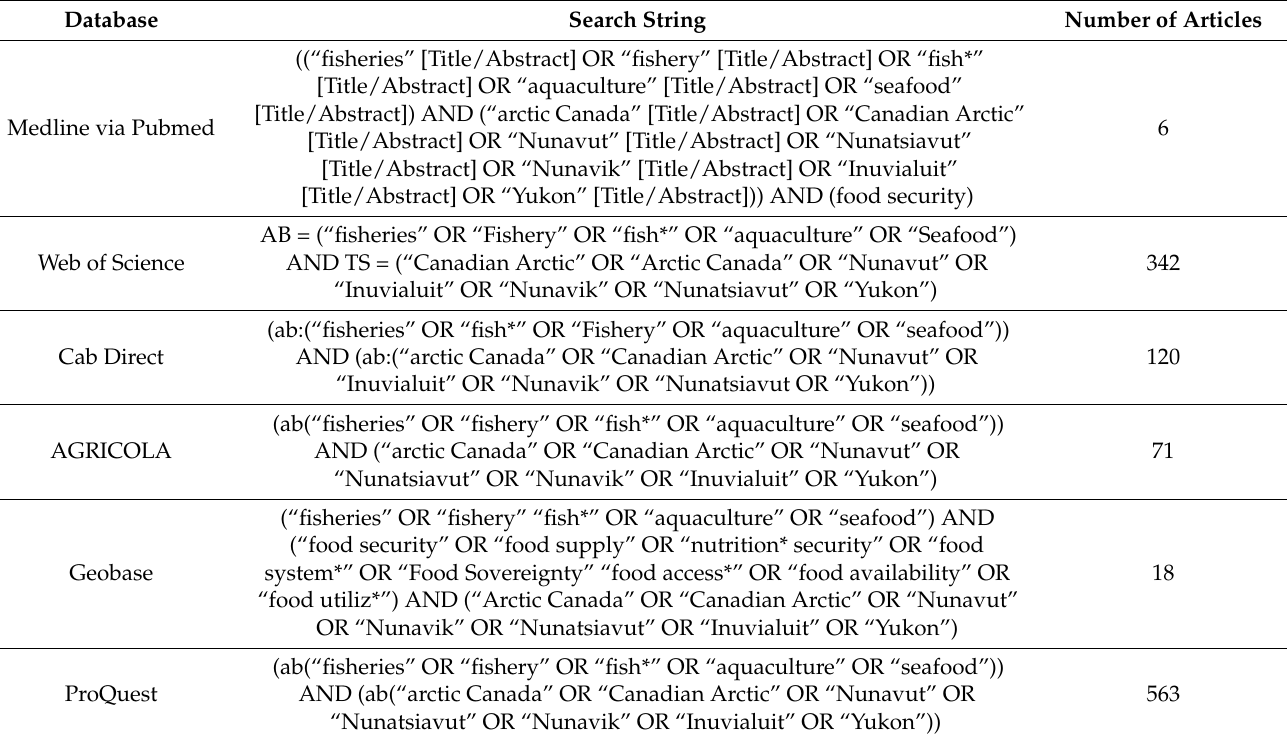
Table A2. Complete search strategy for PubMed, Web of Science, Cab Direct, AGRICOLA, Geobase, and ProQuest. Filtered for